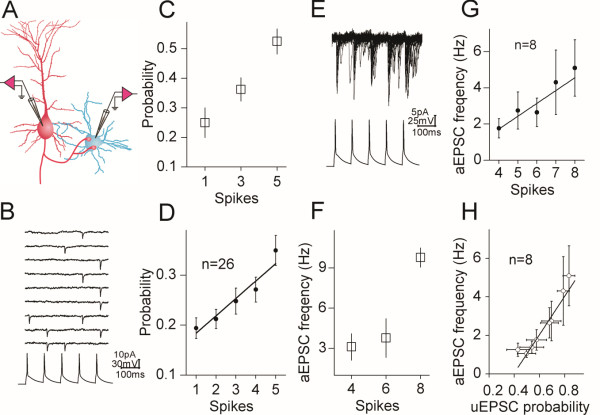
The probability of releasing glutamates increases during sequential presynaptic spikes in a linearly correlated manner. A) shows a diagram for the pair-recording of uEPSCs at unitary synapses from a pyramidal neuron to a GABAergic cell. B) shows synaptic responses evoked by five sequential spikes in a low glutamate release probability. Top traces show the superimposed traces of uEPSCs at a synapse, and a trace in bottom is sequential spikes evoked in presynaptic neuron. C) illustrates the averaged data of spikes vs. their corresponding release probability at this synapse. D) illustrates the averaged data of spikes vs. their corresponding release probability at other synapses (n = 26). E) shows the superimposed traces of uEPSCs and subsequent aEPSCs induced by sequential spikes 4 ~ 8 at a synapse. F) illustrates the averaged data of spikes vs. their corresponding aEPSCs frequency at this synapse. G) shows the averaged data of spikes versus their corresponding aEPSCs frequency at other synapses (n = 8). H) shows a plot of linear correlation between uEPSC1 ~ 8 amplitudes and their corresponding aEPSCs frequency (n = 8). Lines in E~F illustrate linear dynamical fitting.